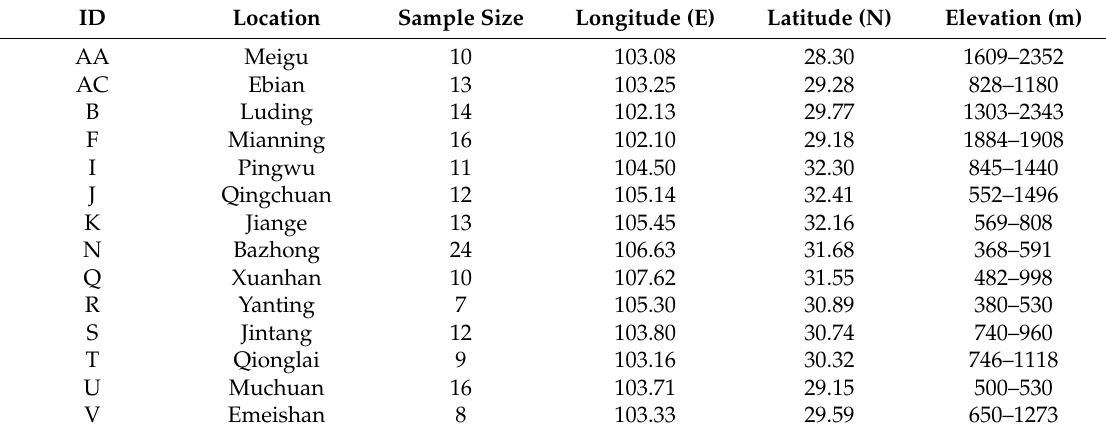
Figure 1. Locations in Sichuan Province of the sampled 14 populations of Alnus cremastogyne. Table 1. Location and number of trees sampled in 14 Alnus cremastogyne populations in Sichuan Province.